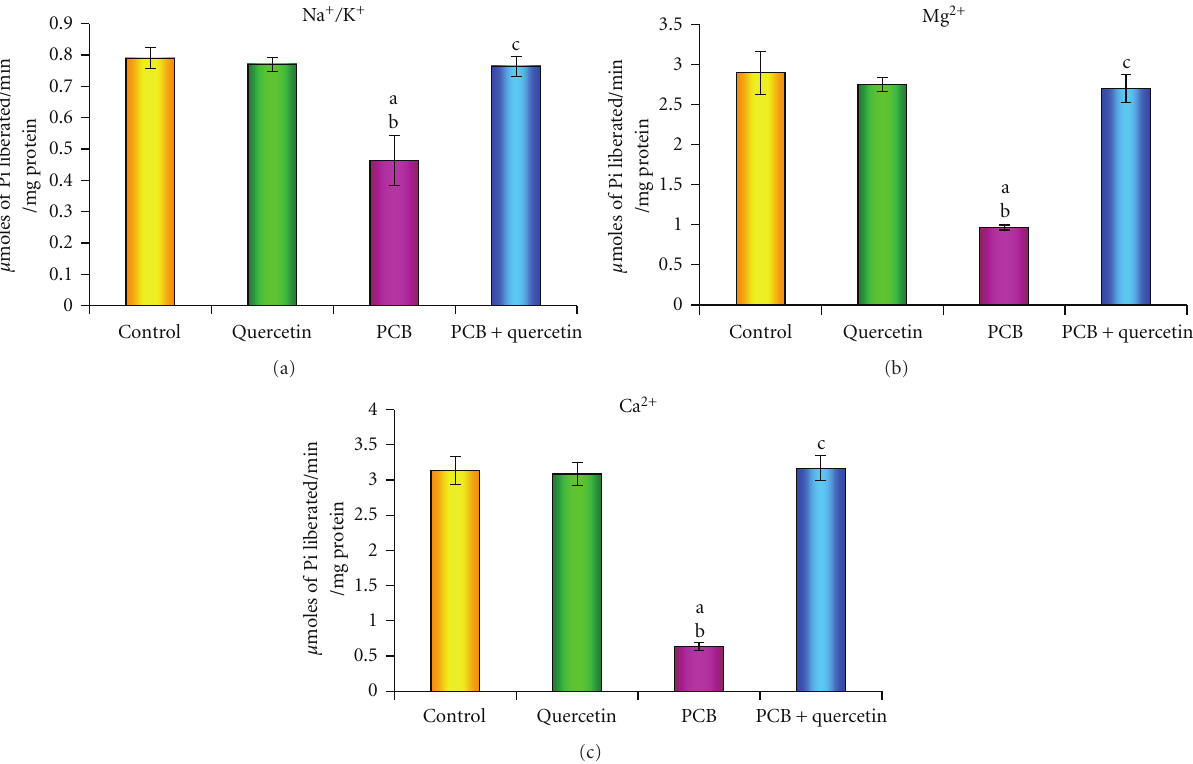
Figure 7: (a), (b), (c): E ff ect of quercetin on Na + /K + , Mg 2+ , and Ca 2+ -ATPases activities in hippocampus of PCBs-exposed adult rats. Each bar represents mean ± SEM of 6 animals. Statistical significance is at P < 0 . 05 (a: Control versus others; b: Quercetin versus PCB, PCB + Quer; c: PCB versus PCB +